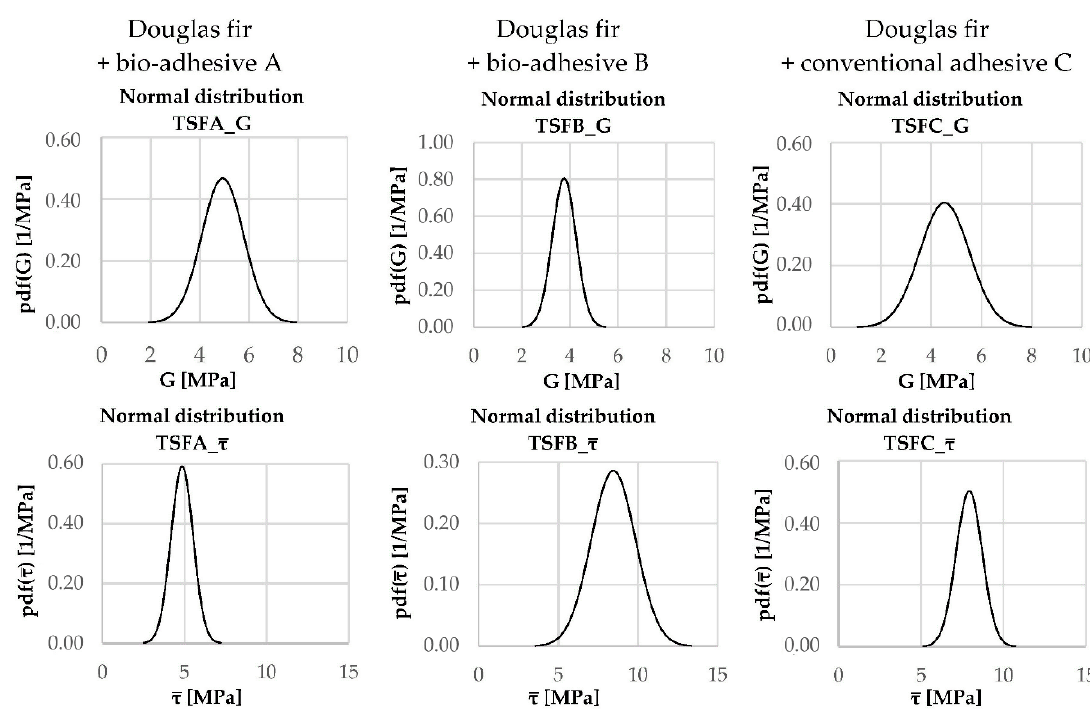
Figure A3. Statistical analysis for shear properties by tensile loading on Douglas fir lap joint specimens.